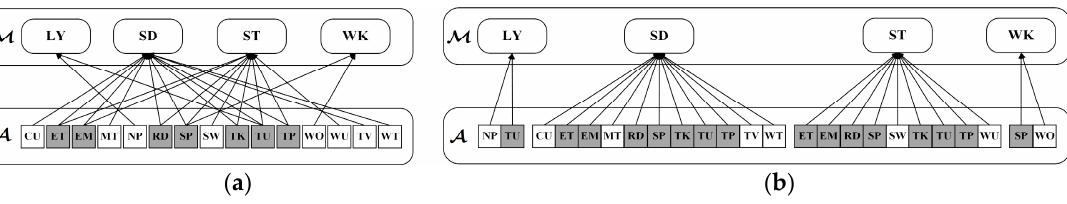
Figure 3. Hierarchical relationship of the correspondence C A↔M defined by Equation (5). ( a ) is the original correspondence of C A↔M ; ( b ) is the converted group correspondence of C A↔M